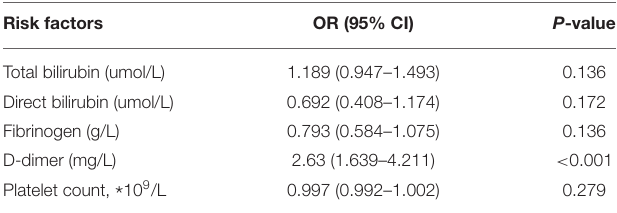
TABLE 5 | Multivariable logistics regression analysis in AAA + PAD group and PAD group.